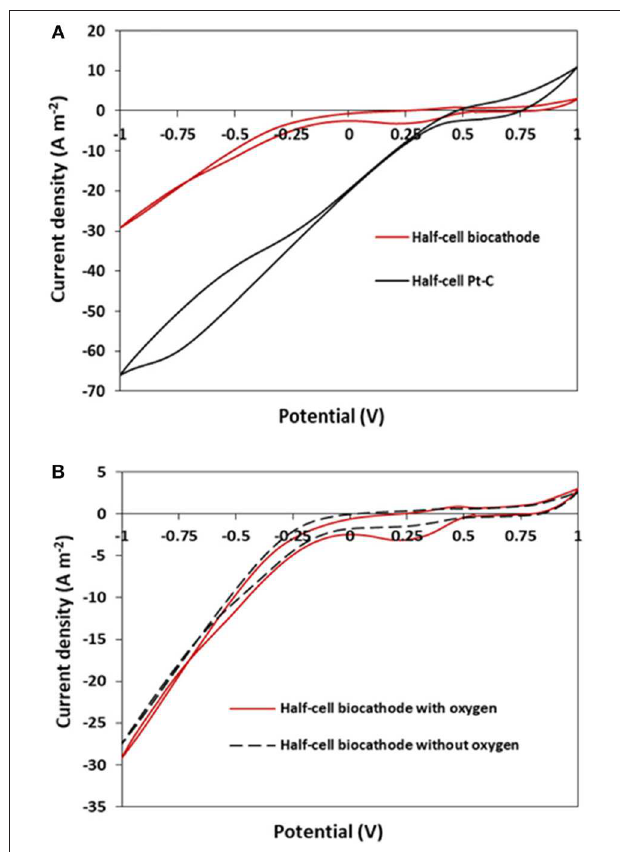
FIGURE 4 | (A) Voltammograms recorded in half-cell reactors equipped with GDEs with Pt-C (black) and IOB biocathode as catalysts (red); (B) voltammograms recorded in half-cells reactors equipped with GDEs and IOB biocathode as catalyst after 47 days of operation, in presence (red) and absence (dashed black) of oxygen. CVs recorded at a scan rate of 2mV s − 1 .